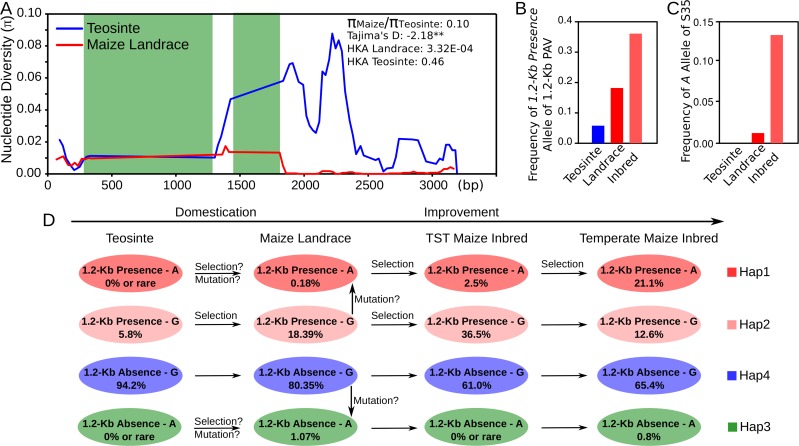
The evidence of significant selection in KRN4 during maize domestication and improvement.A) Nucleotide diversities (π) within ~3 Kb of KRN4 for maize landrace (red line) and teosinte (blue line). The green shades represent the 1.2-Kb PAV region. **: P-value < 0.01. B) Allele frequencies of 1.2-Kb Presence of 1.2-Kb PAV in teosinte, maize landrace and inbred lines. C) Allele frequencies of A of S35 in teoisnte, maize landrace and inbred lines. D) A putative evolutionary pattern of 1.2-Kb PAV and S35 during maize domestication and improvement. The circles in colors represent the four haplotypes between 1.2-Kb PAV and S35. The genotypes of haplotypes in 1.2-Kb PAV and S35 are showed in the circles. The number inside the circle is the frequency of the haplotype. TST maize: Tropical and SubTropical maize germplasms. All of the steps marked as “Selection” are of significantly frequency change, P-value < 0.001 (χ2 test based on the frequencies).